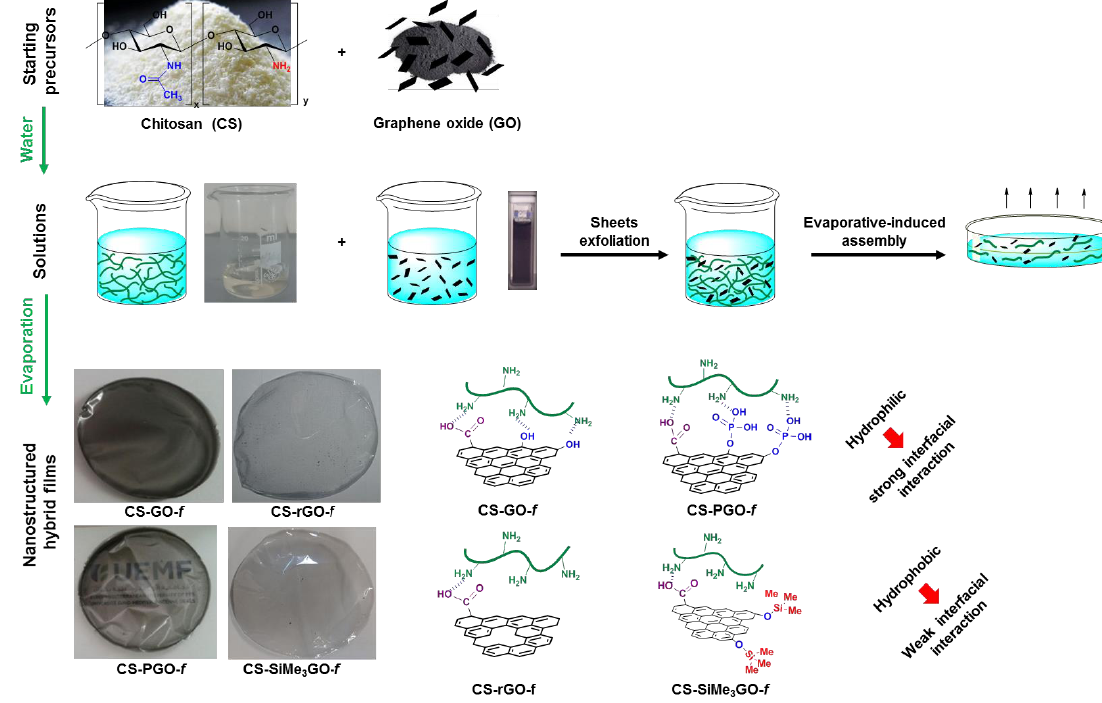
Figure 2. Preparation of chitosan-reinforced-functionalized graphene films. From top to bottom: raw precursors, their solutions, and their subsequent evaporation to provide transparent films. Digital photos of the four films as prepared. Right. Illustration of the molecular interplay occurring at the nanocomposite interface.